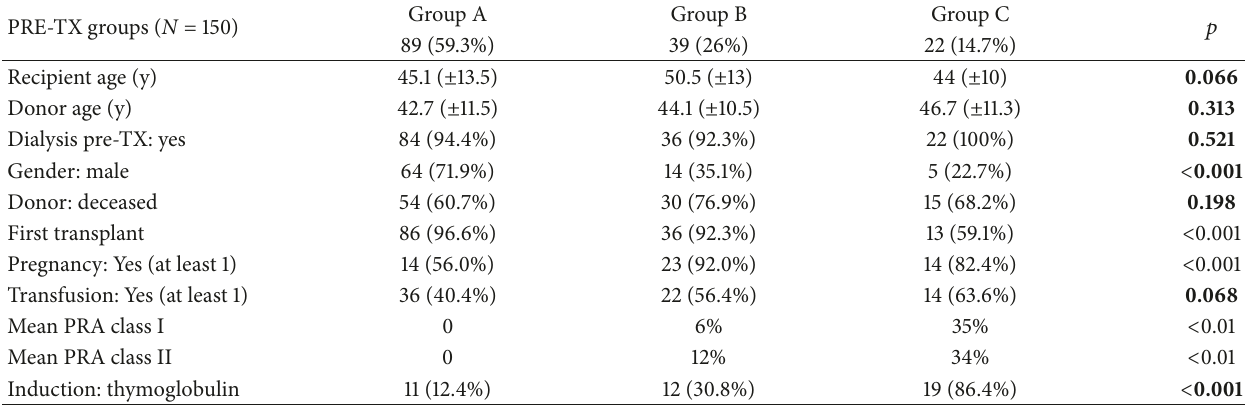
Table 1: Baseline patient characteristics.